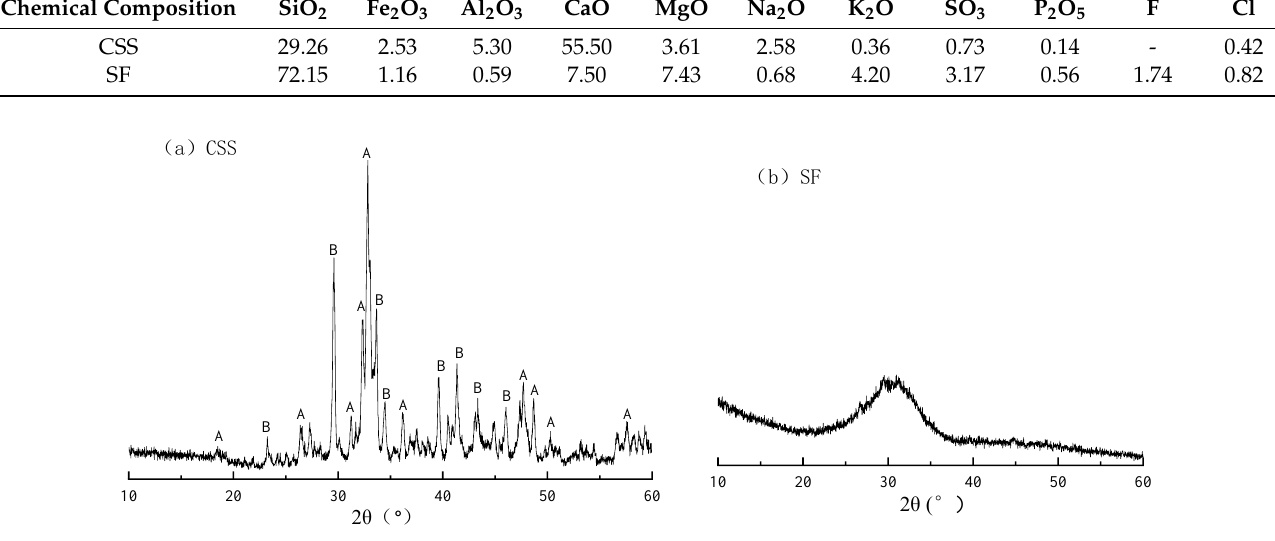
Figure 1. XRD patterns of CSS and SF; ( a )- β - dicalcium silicate (β -2CaO·SiO 2 ) ( b )-calcite (CaCO 3 ).